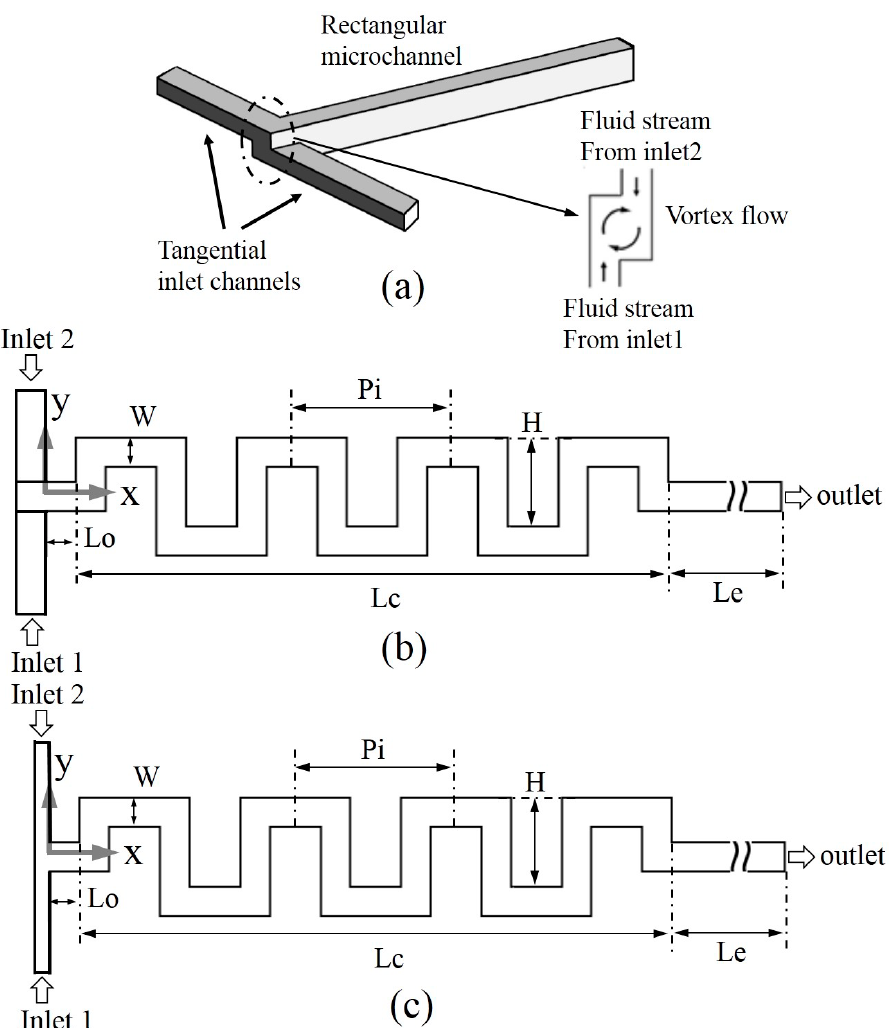
Figure 1. Schematic diagrams of micromixers: ( a ) Basic idea of the vortex T-mixer with tangentially aligned inputs; ( b ) serpentine micromixer with tangentially aligned input channels; and ( c ) serpentine microchannel with simple planar T-Joint